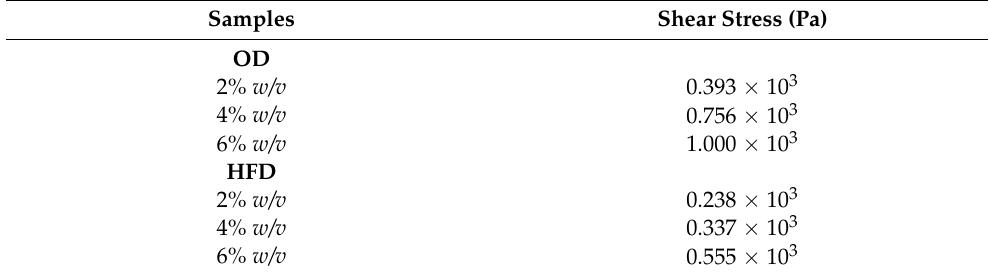
Table 6. Shear values measured for each sample at the fixed shear rate value of 3.55 × 10 − 1